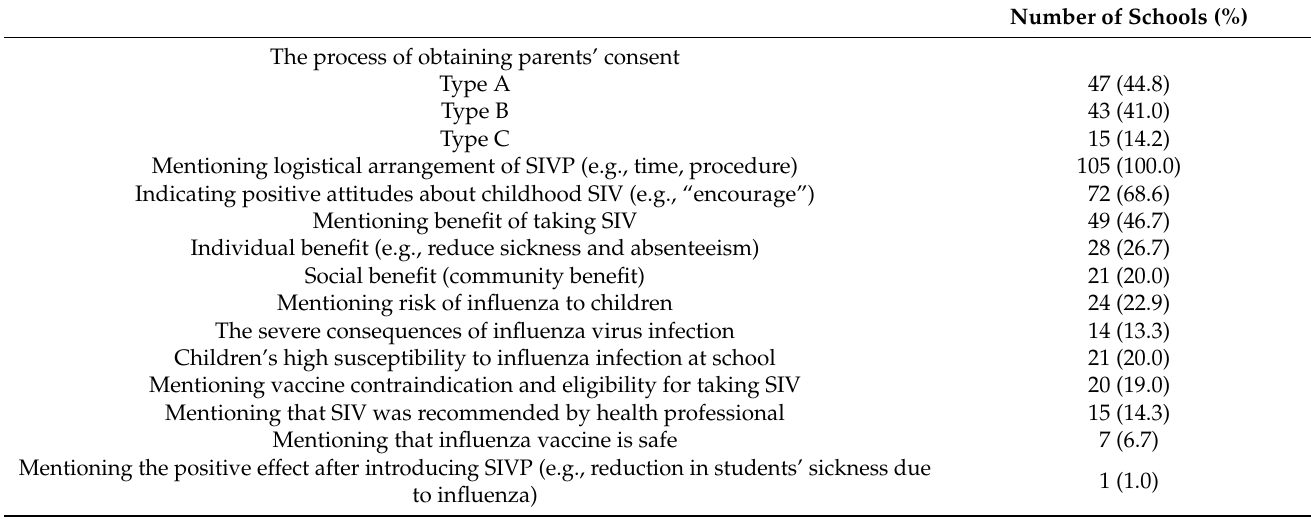
Table 3. Thematic category and their frequency identified from the retrieved school newsletters ( N =